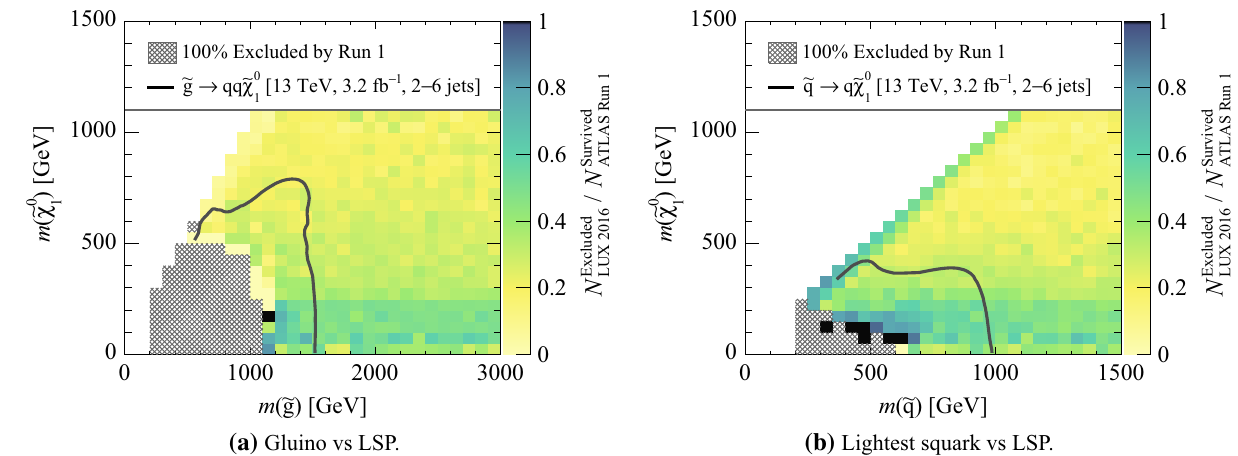
Fig. 10 Fraction of models excluded by the observed 90% confidence limit on the spin-independent LSP-nucleon cross section from the LUX 2016 result [109], projected into the mass plane of the gluino ( left ) and lightest squark ( right ) vs. LSP. Here, m ( ˜ q ) is the lightest squark of the first or second generations. The colour scale for each mass bin indi- cates the number of models excluded by LUX 2016 [78] N Excluded normalised to the number of models that survived ATLAS Run 1 con-